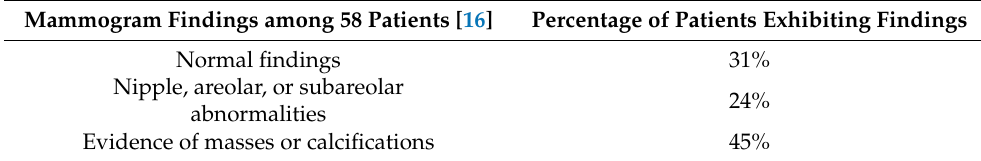
Table 3. Mammographic findings in patients with biopsy-proven